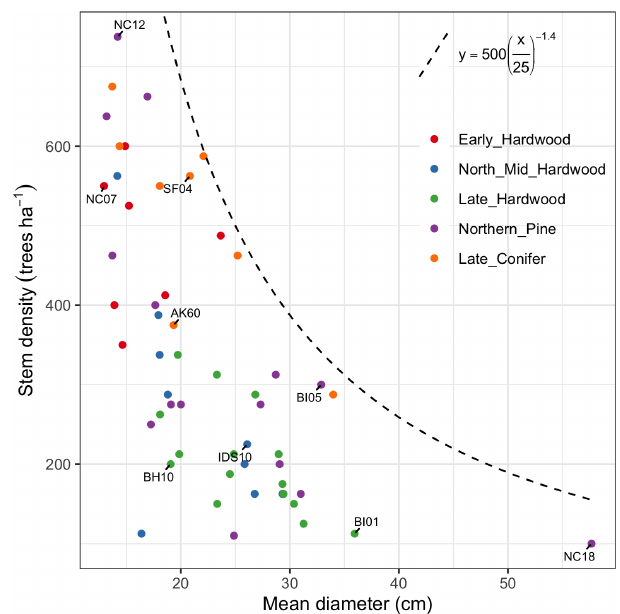
Figure 2. Stand structure and composition characteristics of sites selected for analysis. The dashed line is a forest self-thinning curve (see Zeide, 2010) parameterized based on an analysis of US Forest Service Forest Inventory and Analysis (FIA) data (Travis Andrews, unpublished data). Colors indicate dominant PFT, calculated as the PFT contributing most to site total stem-density-weighted DBH. Sites shown in Fig. 6 are